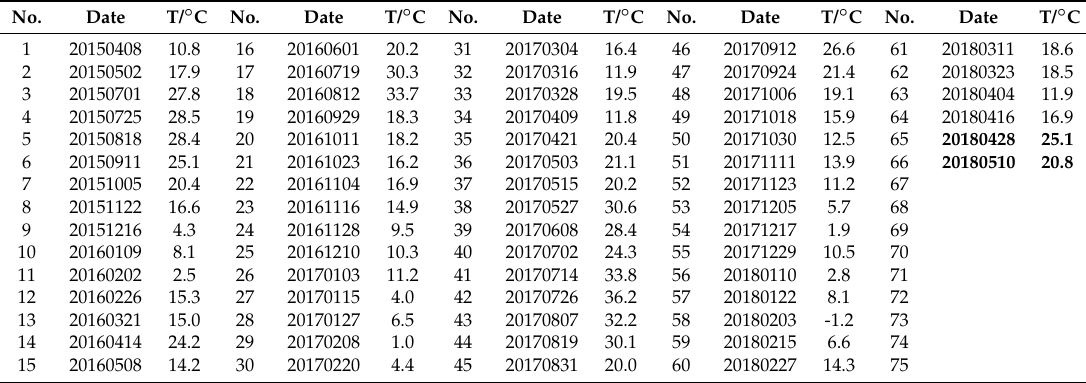
Table 2. Sentinel-1 SAR image dataset of Track 02 (the non-bold group is used for displacement modeling and the bold one for health evaluation).